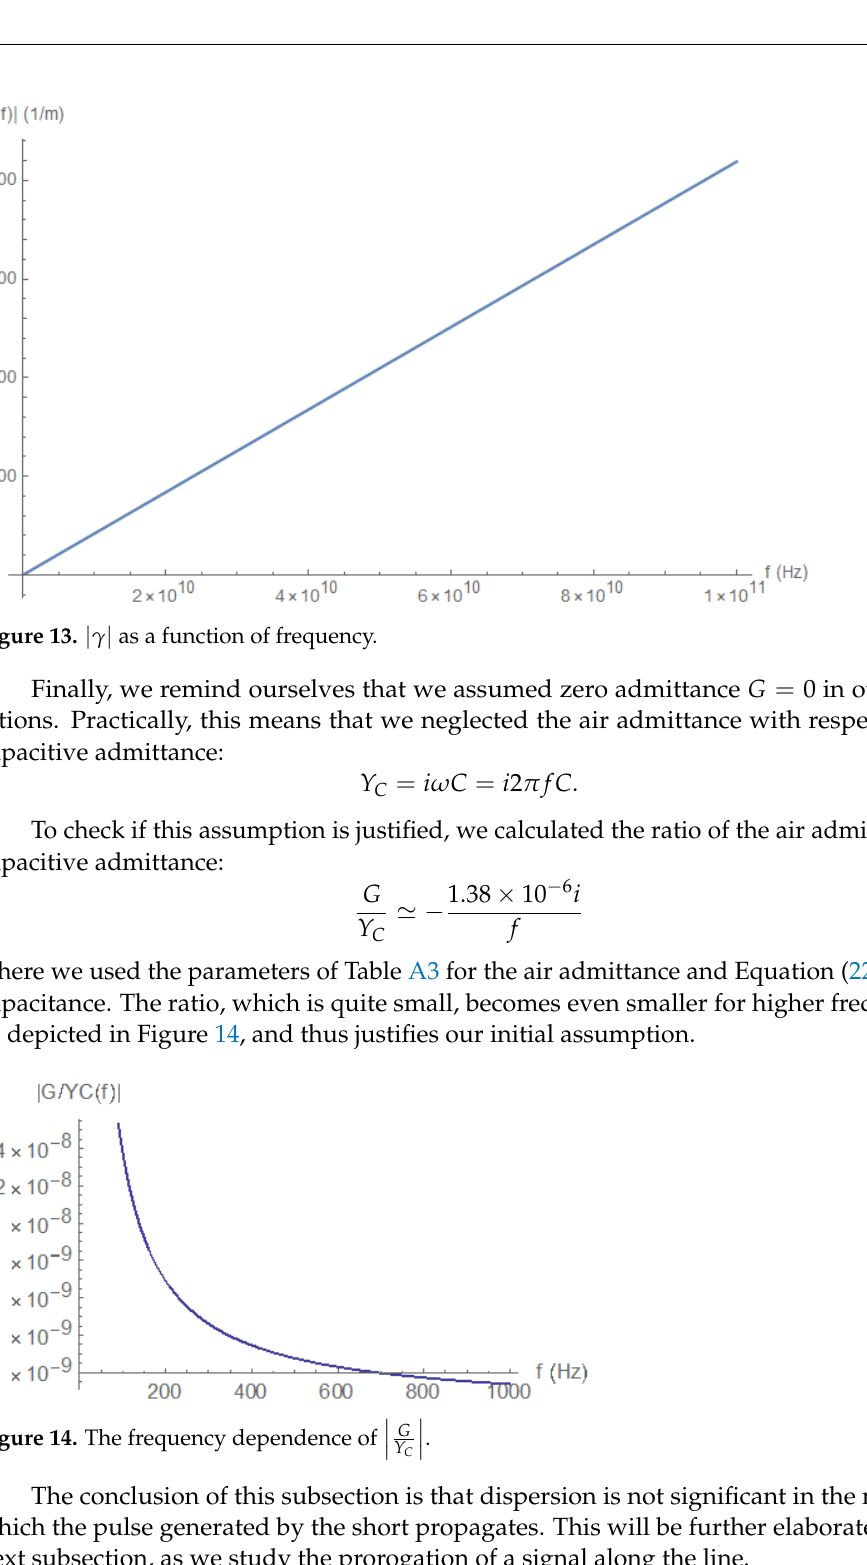
(cid:12) (cid:12) G (cid:12) (cid:12) (cid:12) (cid:12) Y C